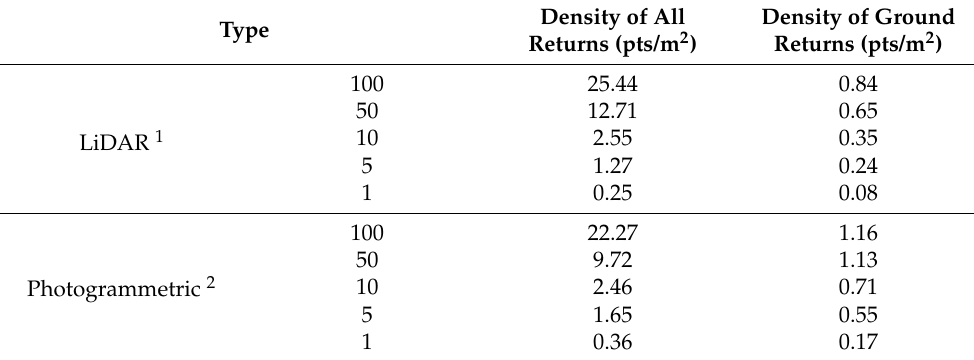
Table 4. Summary of the point cloud return densities.